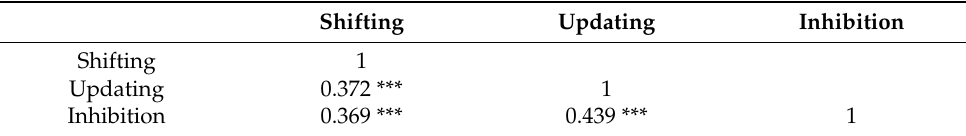
Table 1. Correlation matrix underlying the latent variable